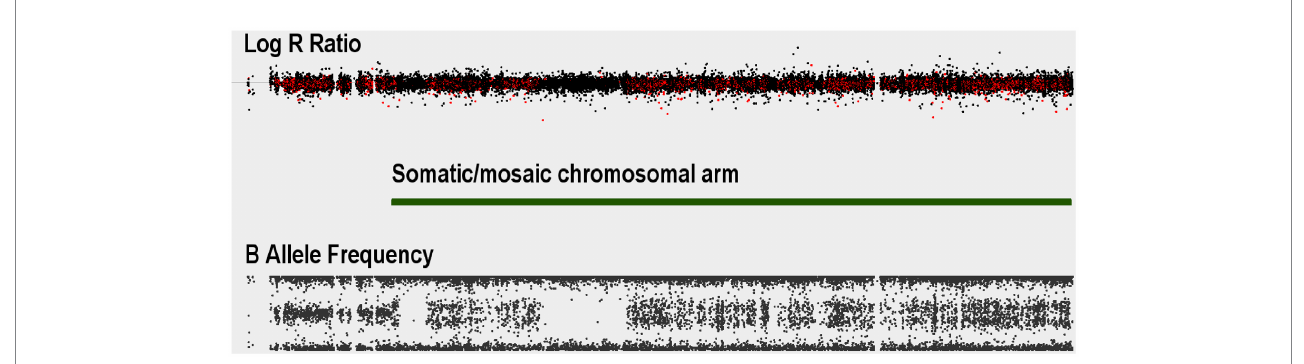
FIGURE 1 Autosomal somatic copy number variant example for a Saudi schizophrenia case: Log R Ratio (LRR) and B-allele frequency (BAF) values for a case with a somatic event spanning almost the entire length of chromosome 15q. The split in the BAF distribution starting at where Genvisis called the breakpoints for the mosaic event (green bar).